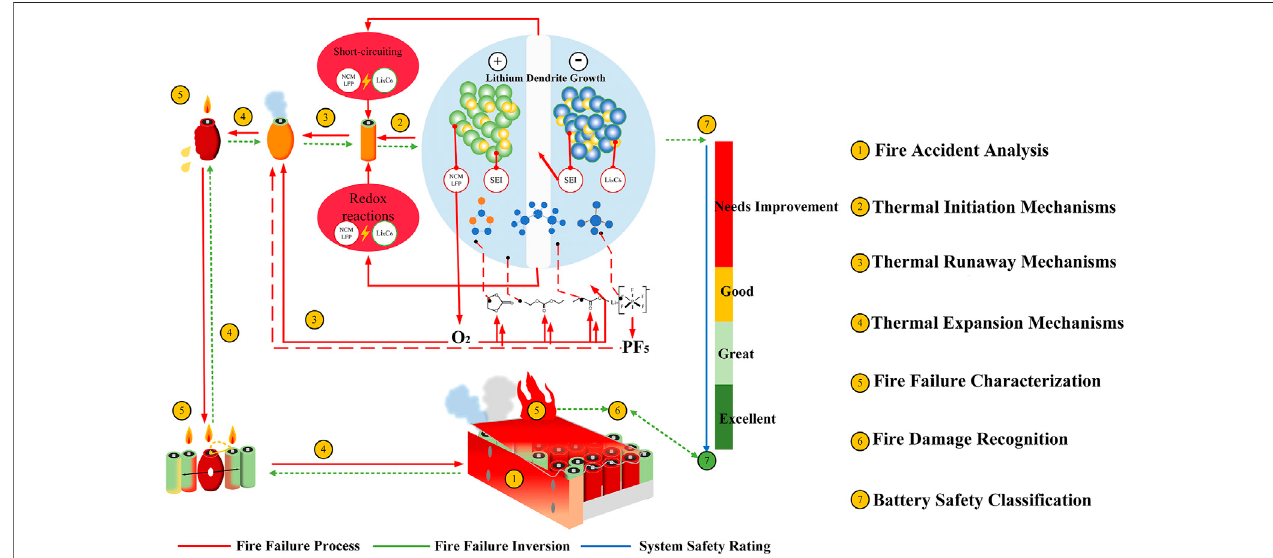
FIGURE 5 | Safety evaluation and rating scheme of cabin-type energy storage based on fi re failure mechanisms.